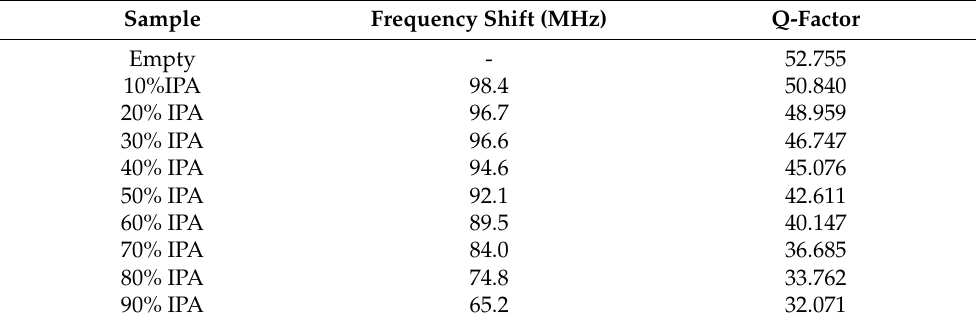
Table 7. The resonant frequency and Q-factor of different concentrations of IPA-water solution.